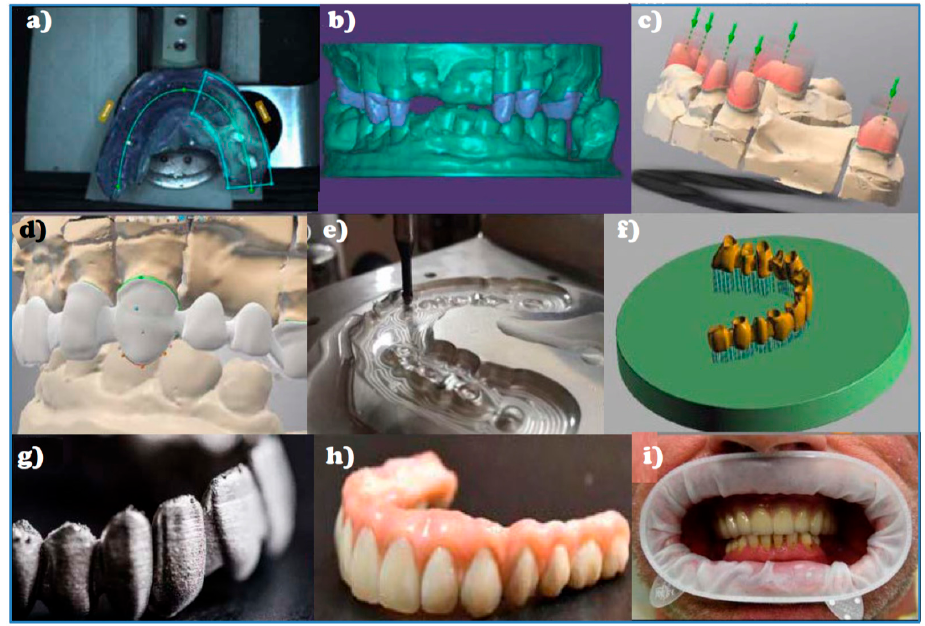
Figure 13. An example of a circumferential bridge after the extraction of the patient’s teeth as a result of neglecting the treatment of caries, alternatively manufactured using the technology of milling solid-state metal blocks or selective laser sintering (SLS) from powders of the Co25Cr5W5MoSi alloy: ( a ) scan of the impression, ( b ) model with finger dentition occlusion, ( c ) verification of the parallelism of the pillars, ( d ) finished design of the skeleton, € milling of the bridge in a controlled numerically controlled center (CNC), ( f ) layout scheme of the bridge selectively sintered with a set of supports on the work table, ( g ) foundation of the bridge manufactured using one of the given technological methods, ( h ) finished bridge veneered with ceramics, ( i ) bridge installed in the patient’s mouth.